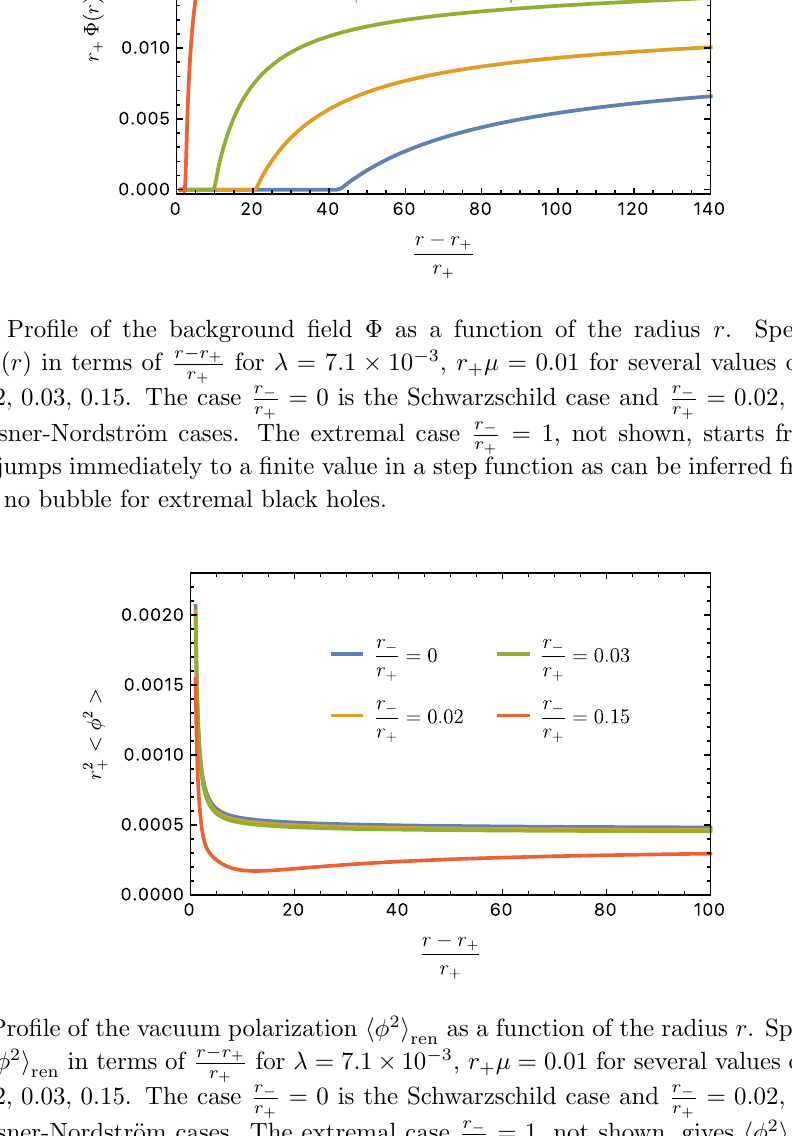
a massless (cid:12)eld as in the Page approximation. On the other hand, in giving a di(cid:11)erent